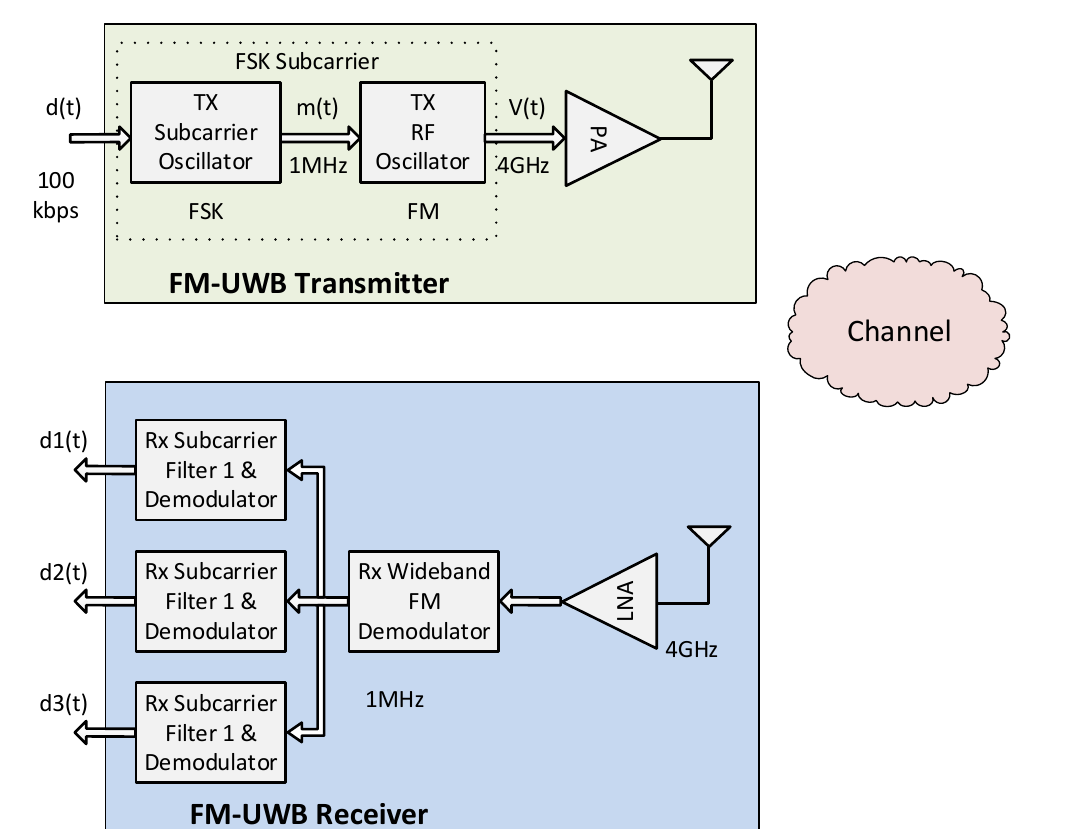
Figure 3. FM-UWB